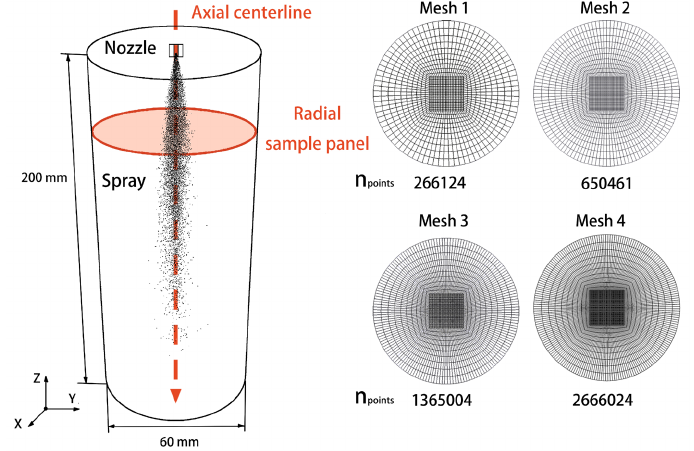
Figure 1. Schematic diagram of the computational domain.